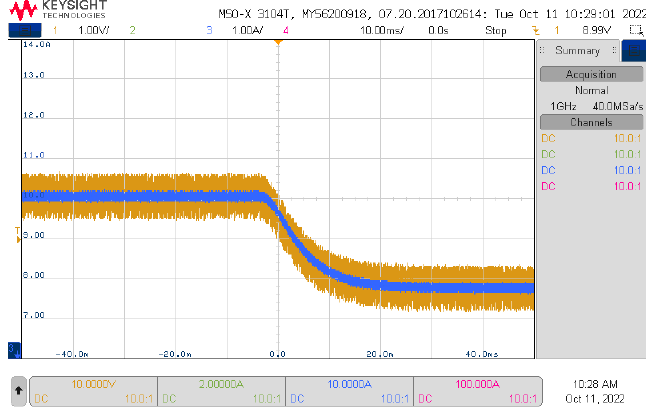
Figure 4. Phase portrait for the PI+PBC method implemented in the boost converter.